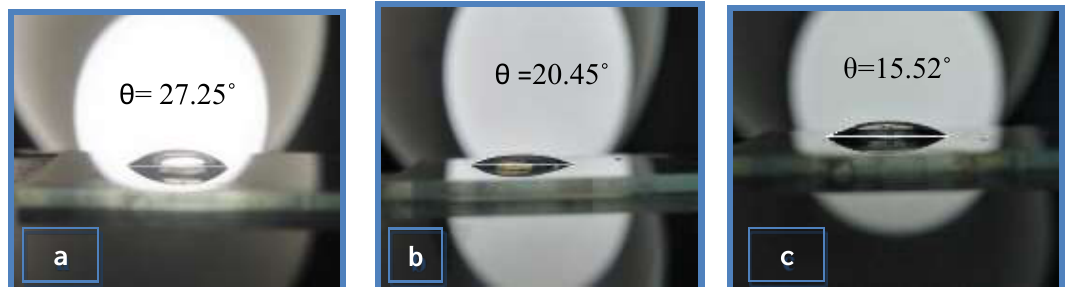
(Tm1): a-15min Vis irradiation, 2